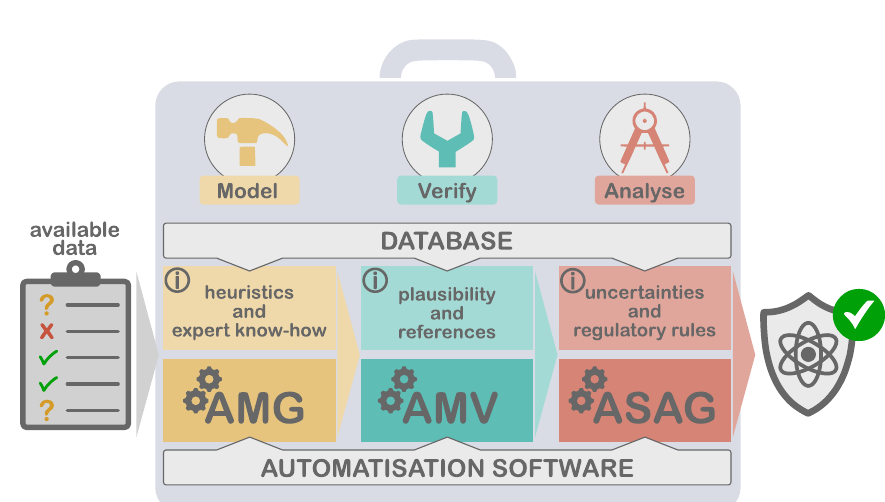
Fig. 2. State of the art DSA vs. innovative approach of RESA-TX.